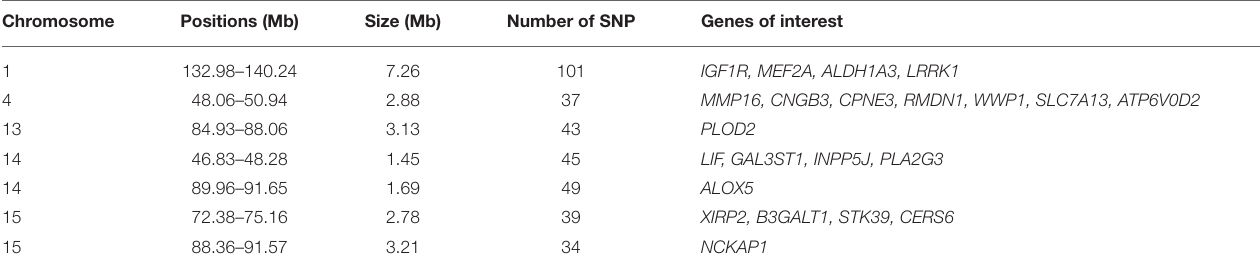
TABLE 1 | Runs of homozygosity (ROH) hotspots in G0 and putative genes of interest under similar selection in the three founder breeds.